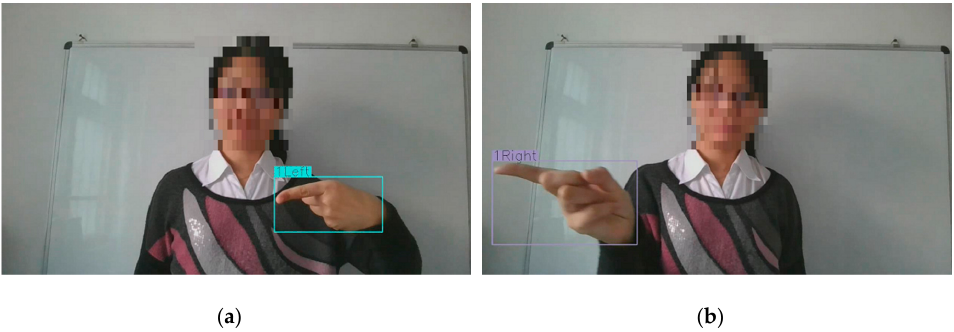
Figure 27. Example of comparison when the system correctly classifies the hand posture and when it Appl. Sci. 2020 , 10 , x FOR PEER REVIEW